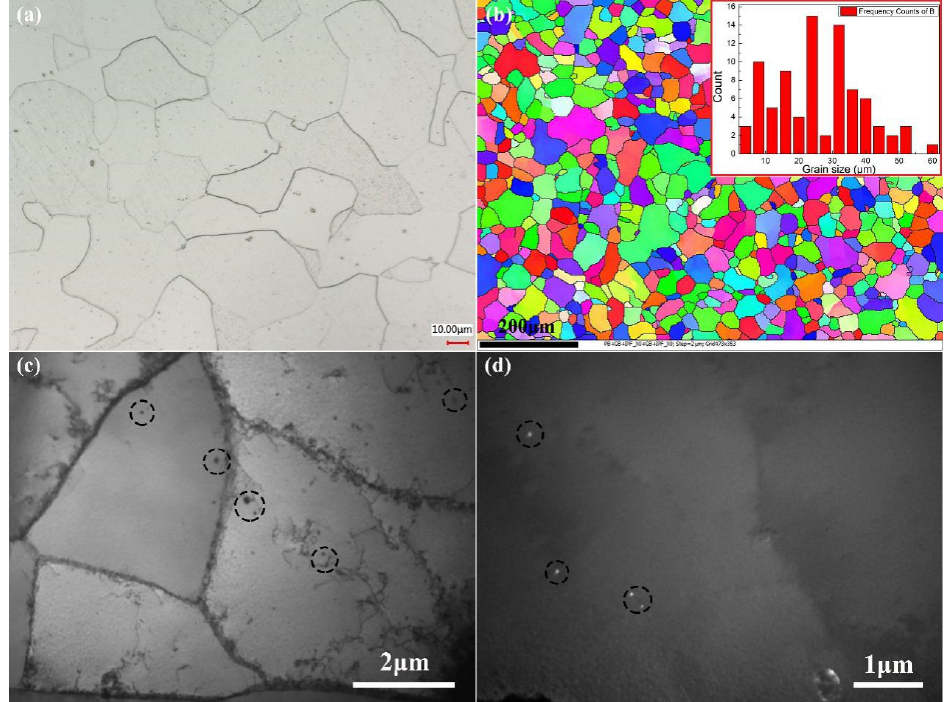
Figure 2. Microstructure of pure iron. ( a ) Light optical microscopy image; ( b ) inverse pole figure; ( c ) TEM image and ( d ) dark field image taken from precipitates. Black dotted circles showing precipitates.